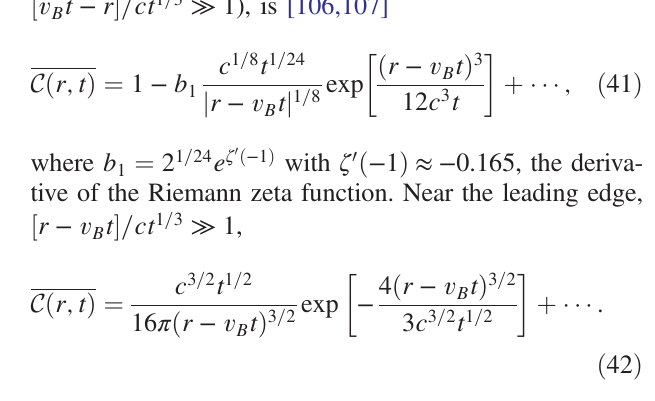
FIG. 8. Fluctuation exponent β : We fit the profile of the evolving droplet for q ¼ 2 along the θ ¼ (cid:4) π = 4 directions (top panel) to extract the mean operator size and magnitude of the fluctuations about the mean. The fluctuations exhibit power-law growth with exponent β ¼ 0 . 3305 (cid:4) 0 . 0269 , consistent with the KPZ value β ¼ 1 = 3 . When fitting the profile along θ ¼ 0 (bottom panel), we observe no appreciable growth of the fluctuations; we argue in Appendix E that this occurs for sufficiently large q when the front ’ s local normal vector is precisely aligned with a lattice axis (as a result of the specific circuit